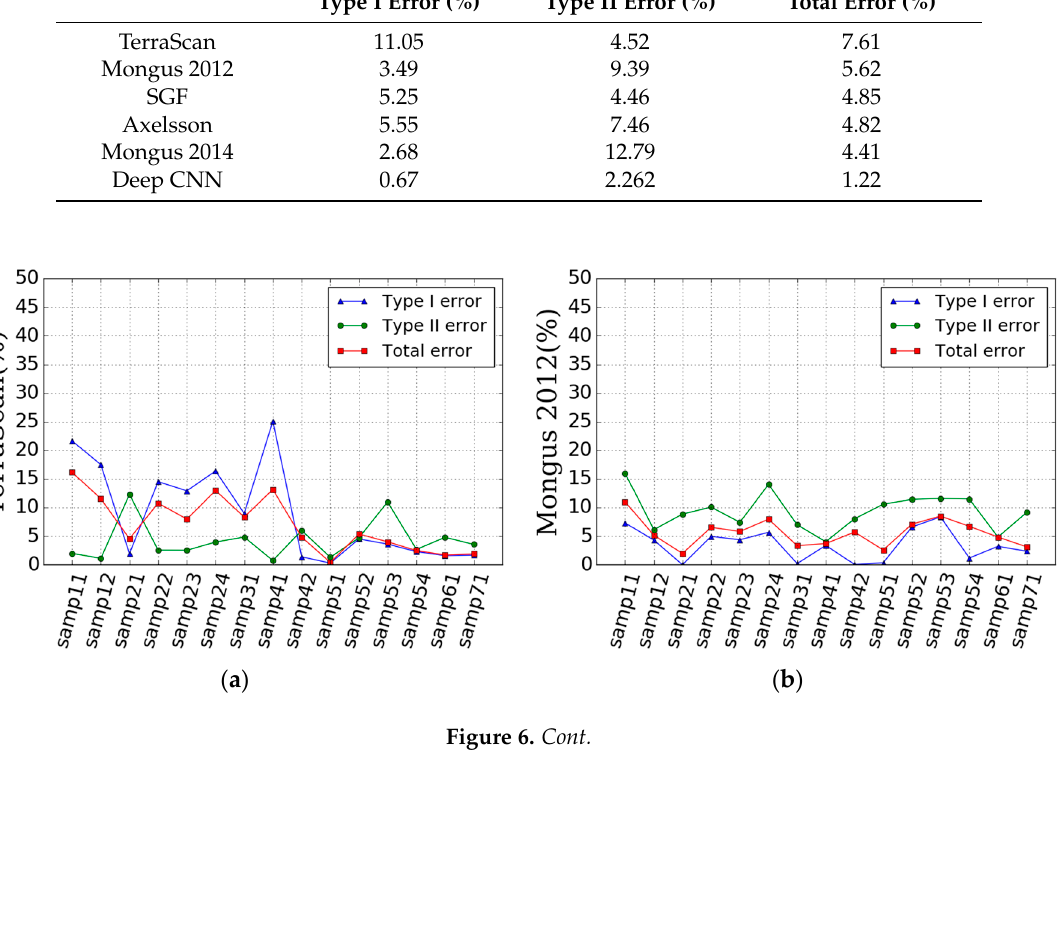
Table 1. Comparison of deep CNN model and other methods on the ISPRS dataset.